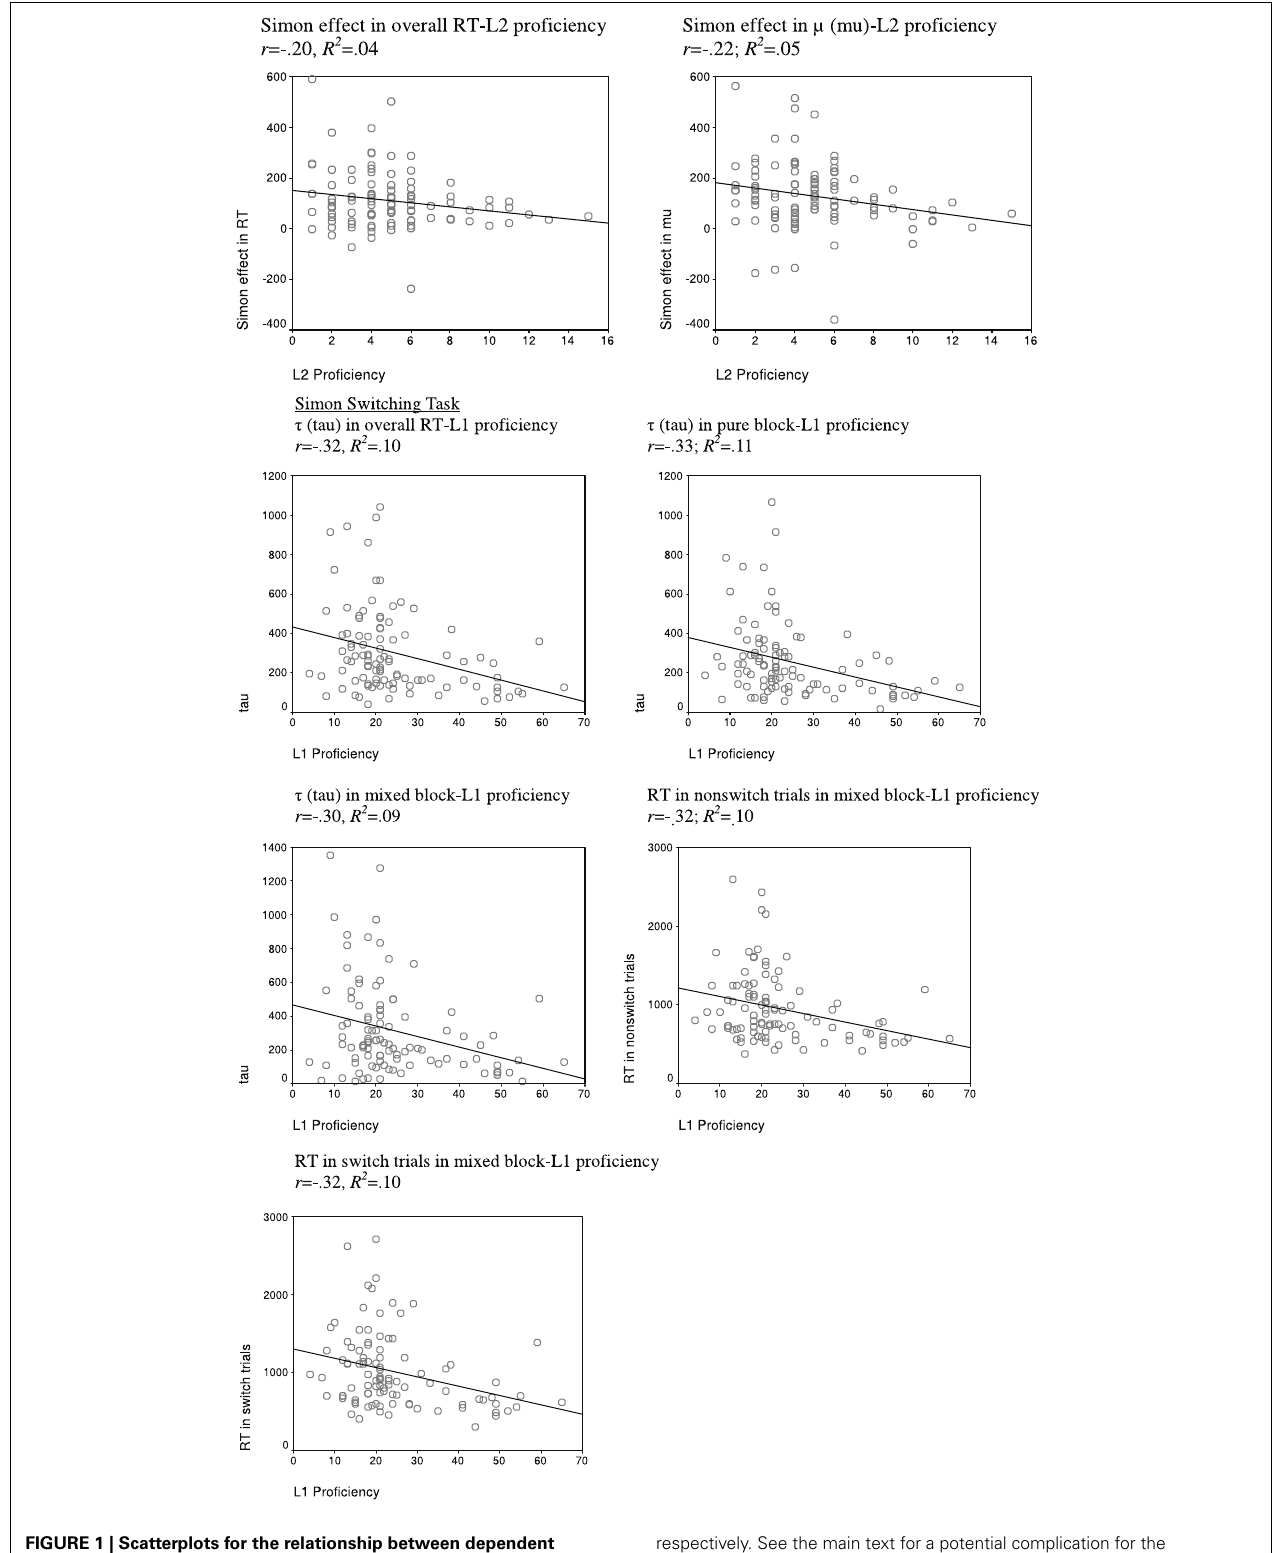
FIGURE 1 | Scatterplots for the relationship between dependent measures and bilinguals’ L1 or L2 proficiency. ( Note : r and R 2 are based on Pearson correlation analyses and the model fit of linear regression,